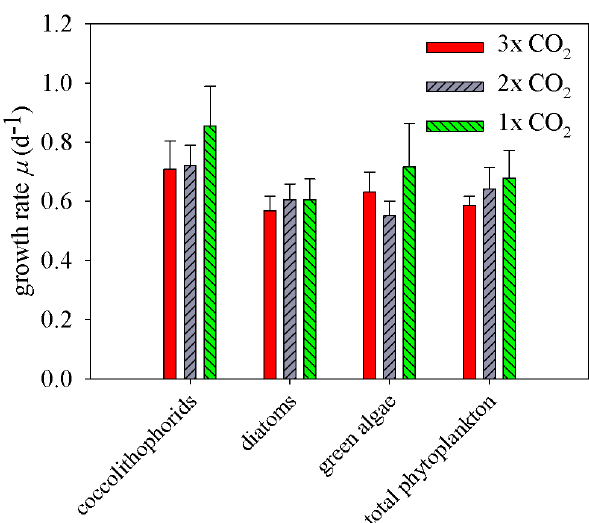
Fig. 5. Phytoplankton group-specific growth rates during the bloom period, day 5–9. Average and SD are